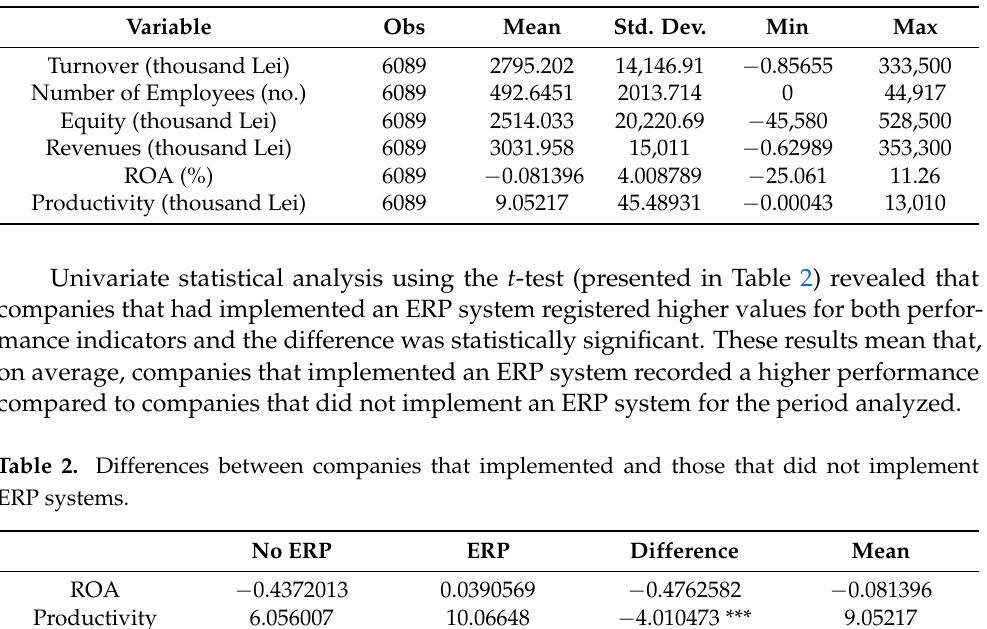
Table 1. Descriptive statistics of variables.